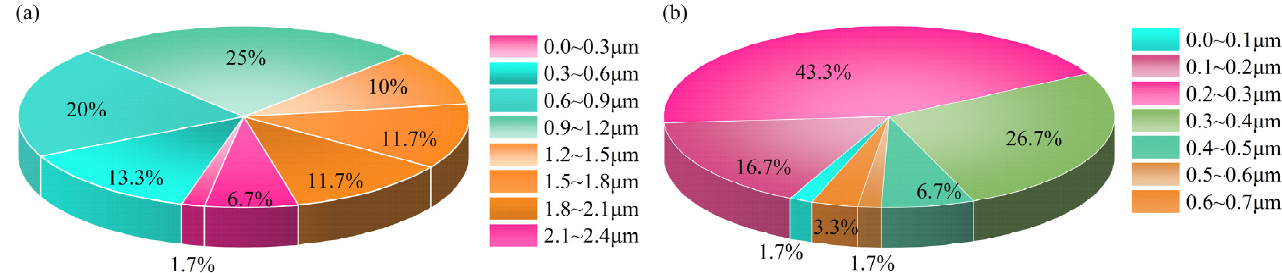
Figure 2. Grain size percentage chart for ( a ) ZIF-67 and ( b ) ZIF-67@MXene hybrids.